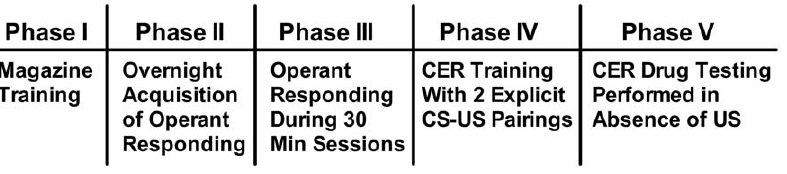
Figure 1. CER training and drug testing schedule. To introduce mice to the location of saccharin delivery, magazine training (Phase I) occurred over days 1–3. CER acquisition of lever pressing maintained by 10 mMol saccharin solution took place during overnight sessions with increasingly demanding schedules of reinforcement (Phase II; days 4–9) until mice reached criteria of 70 reinforcers and 100 s of correct magazine entries in a session. This was followed by daily 30 minute sessions (Phase III) where mice lever pressing was maintained by saccharin under a variable schedule of reinforcement. Mice moved onto the next Phase of training when they reached criteria of 40 lever presses and 10 reinforcers during a single 30 minute session (days 10–13). During CER training mice continued operant training but also received 2 explicit pairings of a light and tone conditioned stimulus (CS) which co-terminated with a 0.1 or 0.3 mA footshock unconditioned stimulus (US) (Phase IV; days 14–43). Phase IV continued until all mice showed a stable level of CS and NON-CS responding over 3 days. Drug testing (Phase V) consisted of lever pressing maintained by saccharin in the presence of the CS but in the absence of the US. For these studies that used a within-subject, Latin square design, there were at least 2 CER training days in between drug testing sessions to assure that mice returned to baseline prior to the next injection of